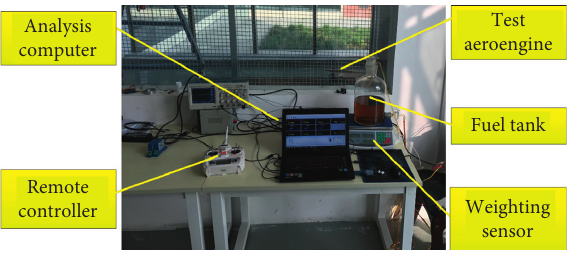
Figure 19: Aeroengine test station.